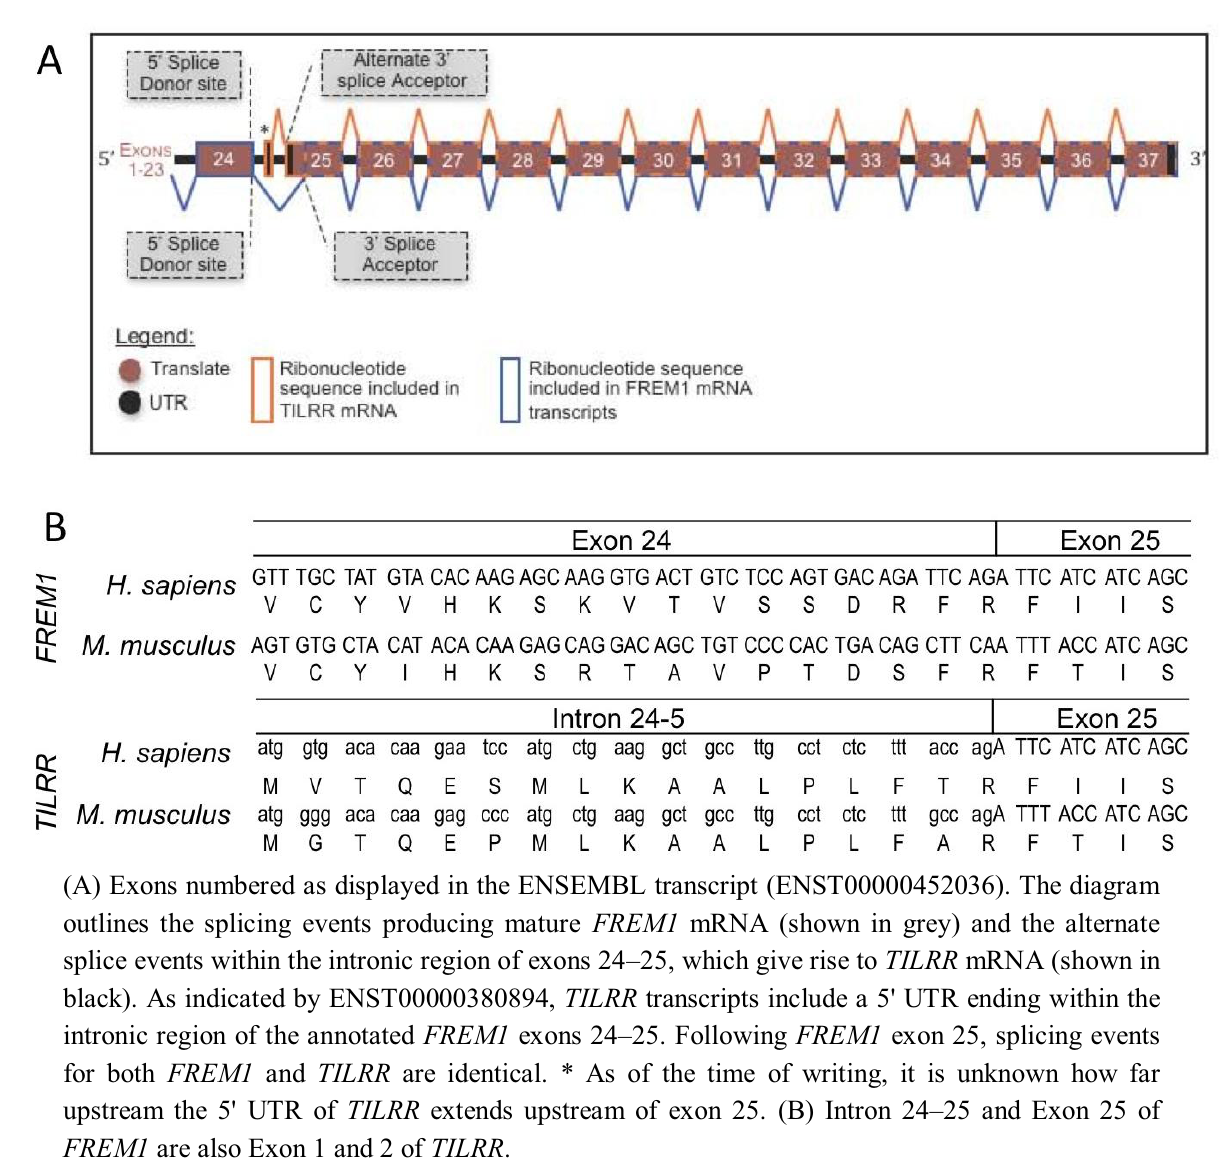
Figure 1. ( A ) Schematic diagram of Human and Mouse FREM1 pre-mRNA. ( B ) DNA sequence and peptide translation of human and mouse FREM1 in region of boundary between exons 24 and 25 (upper panel) and TILRR showing genomic sequence and translated